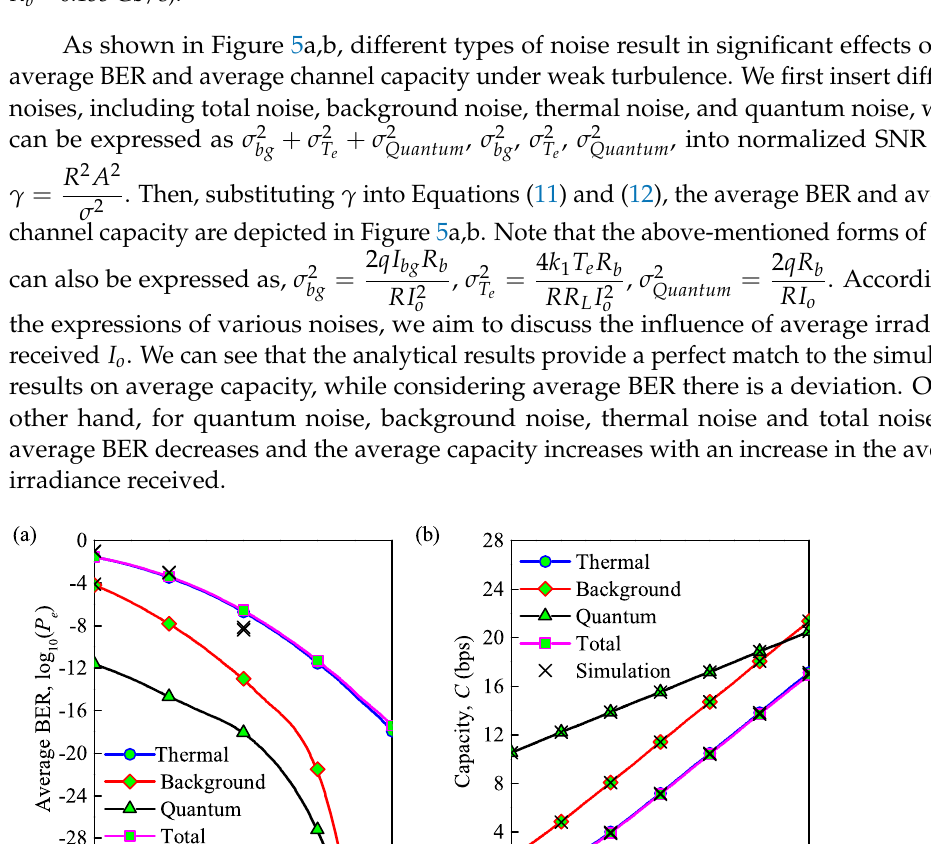
Figure 4. ( a ) Average BER versus link distance for different wavelengths; ( b ) average capacity versus link distance for different wavelengths ( C 2 n = 0.75 × 10 − 14 m − 2/3 for moderate turbulence, T e = 300 K, R b = 0.155 Gb/s).